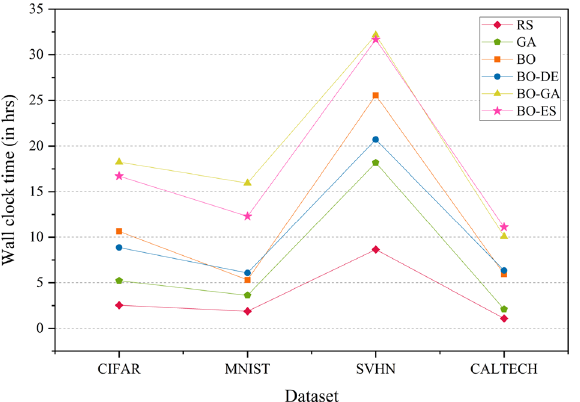
Figure 7. Wallclock time comparison plot of AlexNet model across the datasets—CIFAR, MNIST, SVHN and CALTECH. The model uses RS, GA, a BO framework for HPO with L-BFGS, BO-DE, BO-GA and BO-ES.